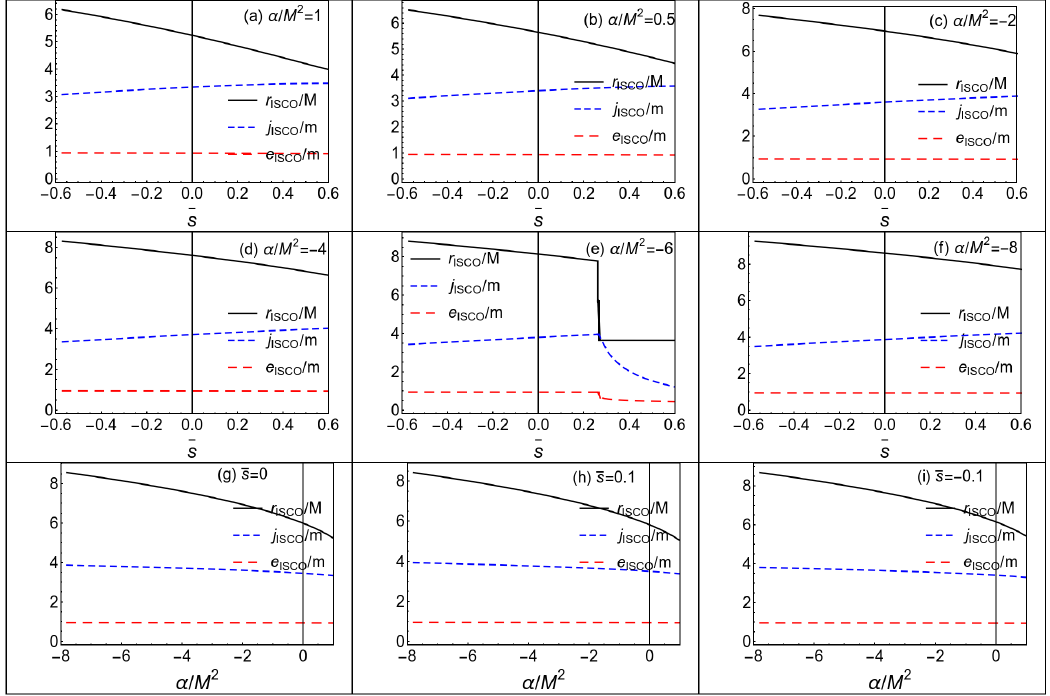
Figure 5. The ISCO parameters of the spinning test particle with different values of α . The parameters are set as M = 1 and m =